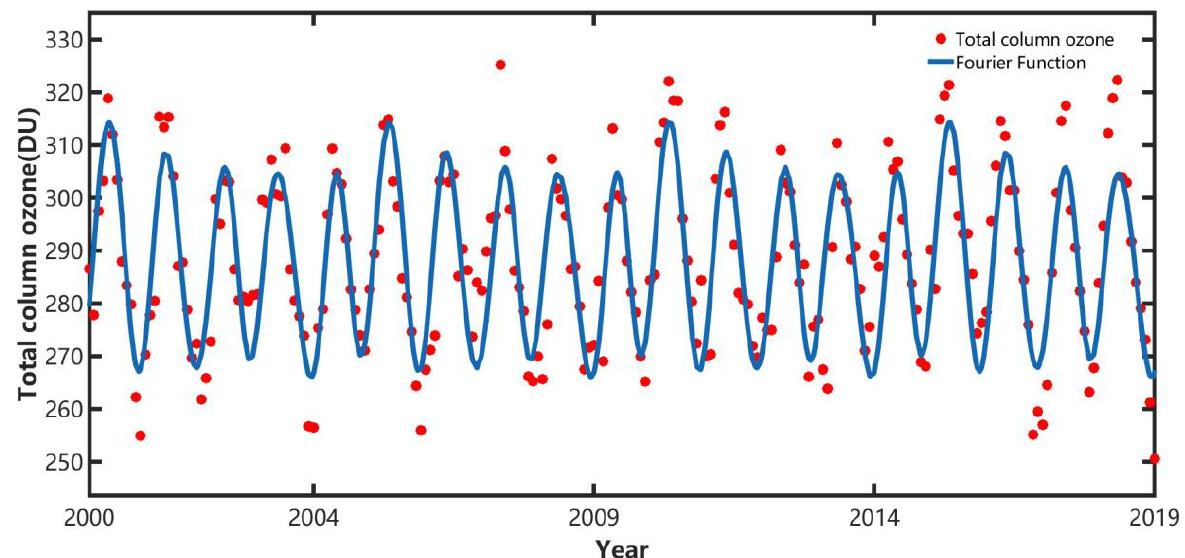
Figure A7. Fourier function fit plots of historical results of monthly changes in the TCO for the Yangtze River Delta Urban Agglomeration from 2000 – 2019. Notes: y=287.9 − 1.688 × cos(x ×